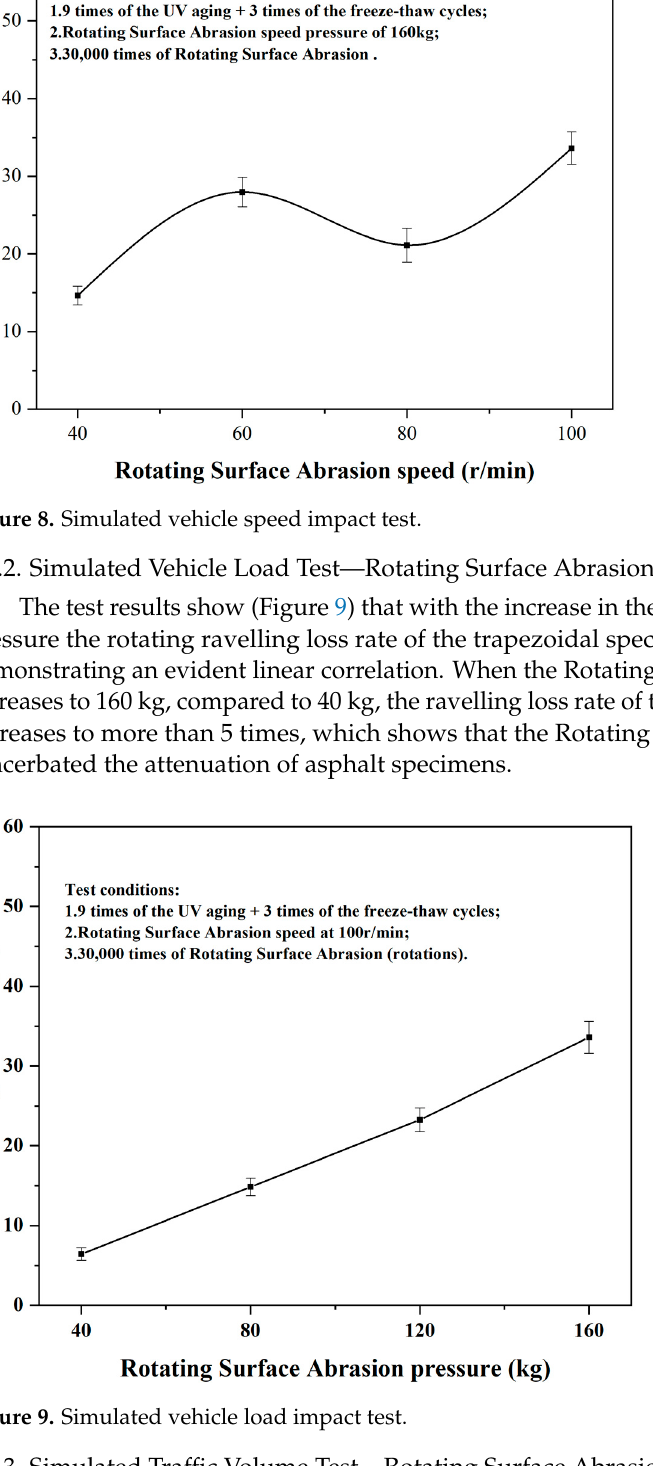
Figure 10. Test results of simulated traffic volume.